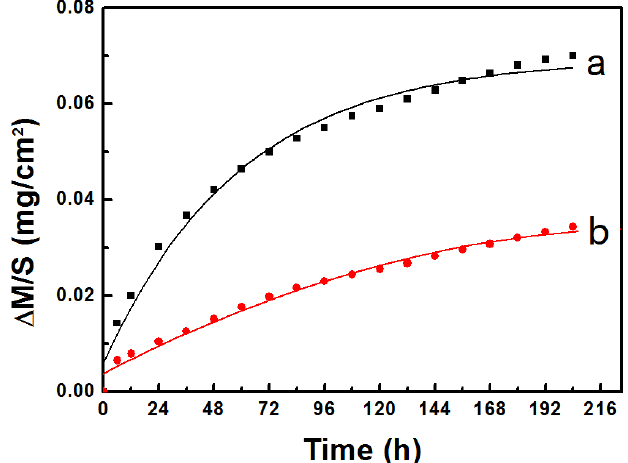
Figure 9. Weight gain of bondcoat samples as a function of oxidation time for ( a ) as-sprayed sample, ( b ) Al coated sample. The cyclic oxidation was carried out at 1050 °C for 204 h.